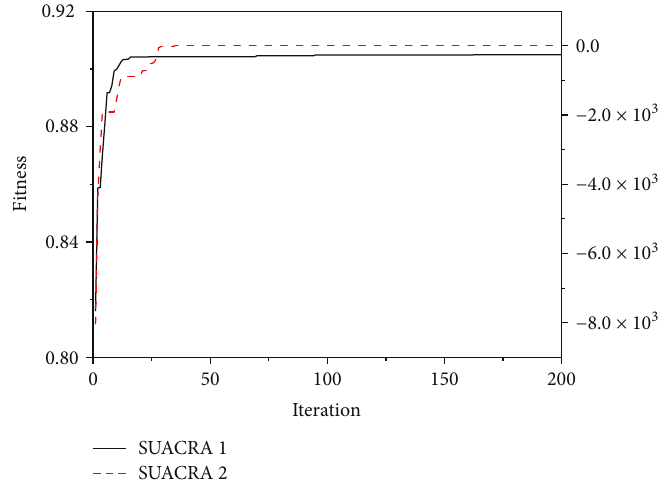
Figure 6: The fi tness values throughout the optimization process of SUACRA 1 and 2. Table 3: Performance comparison of the SUACRA 3, 4, and the